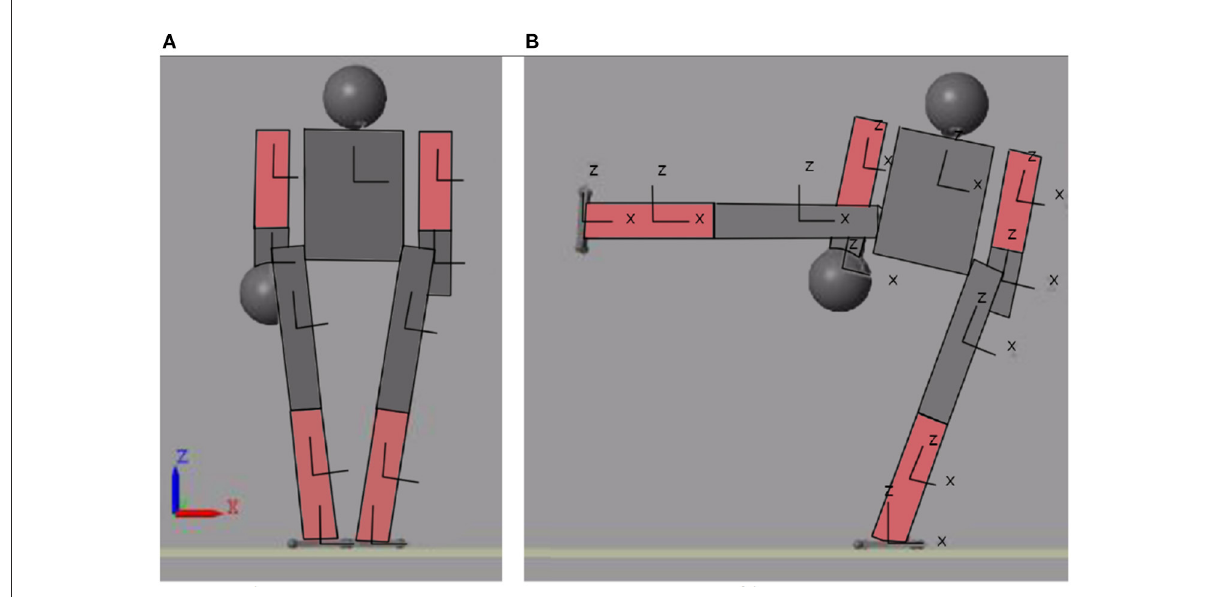
FIGURE14 Initial and final position of the movement seen from the XZ plane. (A) Initial position of motion. (B) Final position of motion.